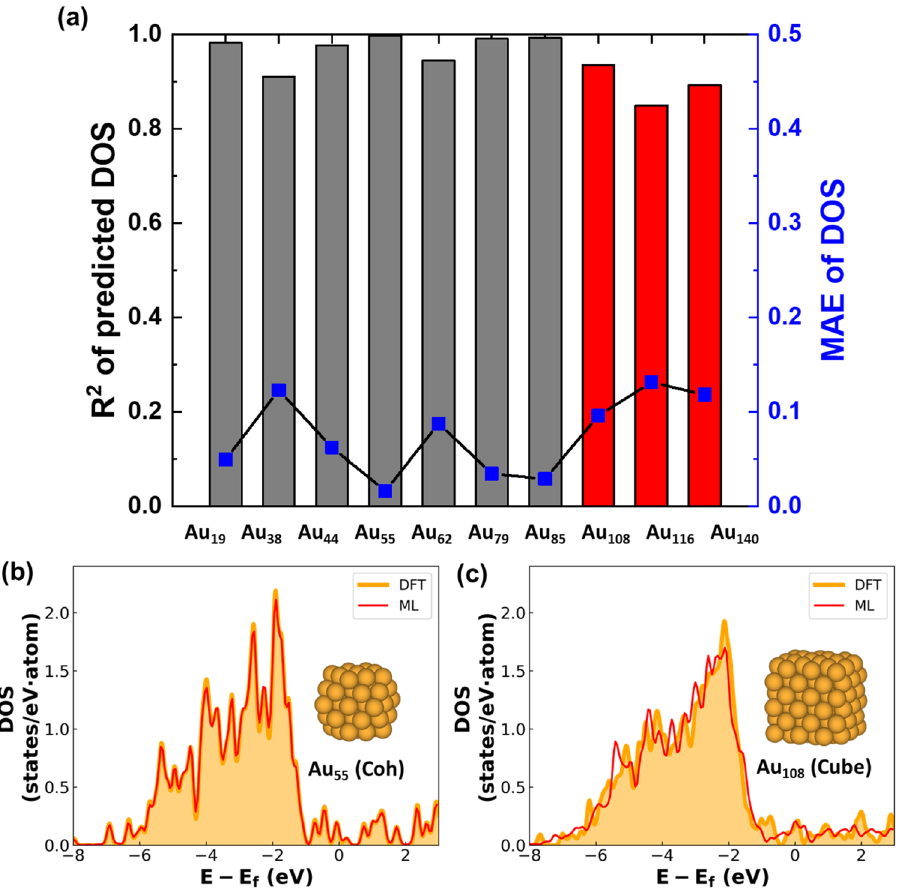
Figure 3. PCA-CGCNN performance on Au NPs. ( a ) The DOS pattern similarity (R 2 and MAE) of our PCA- CGCNN model compared to DFT methods. Here, pure Au NPs are considered. Bars indicate R 2 value and blue squares indicate MAE. Gray bars indicate training data, and red bars indicate test data. ( b , c ) Comparison of DOS patterns for Au